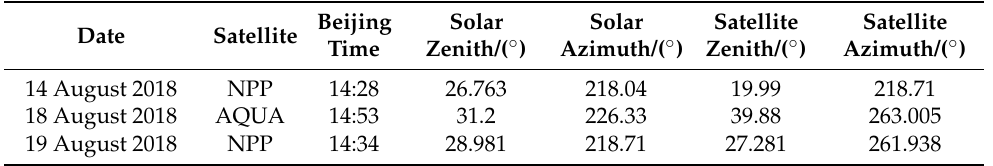
Table 4. Geometric parameters of Aqua/MODIS and NPP/VIIRS.